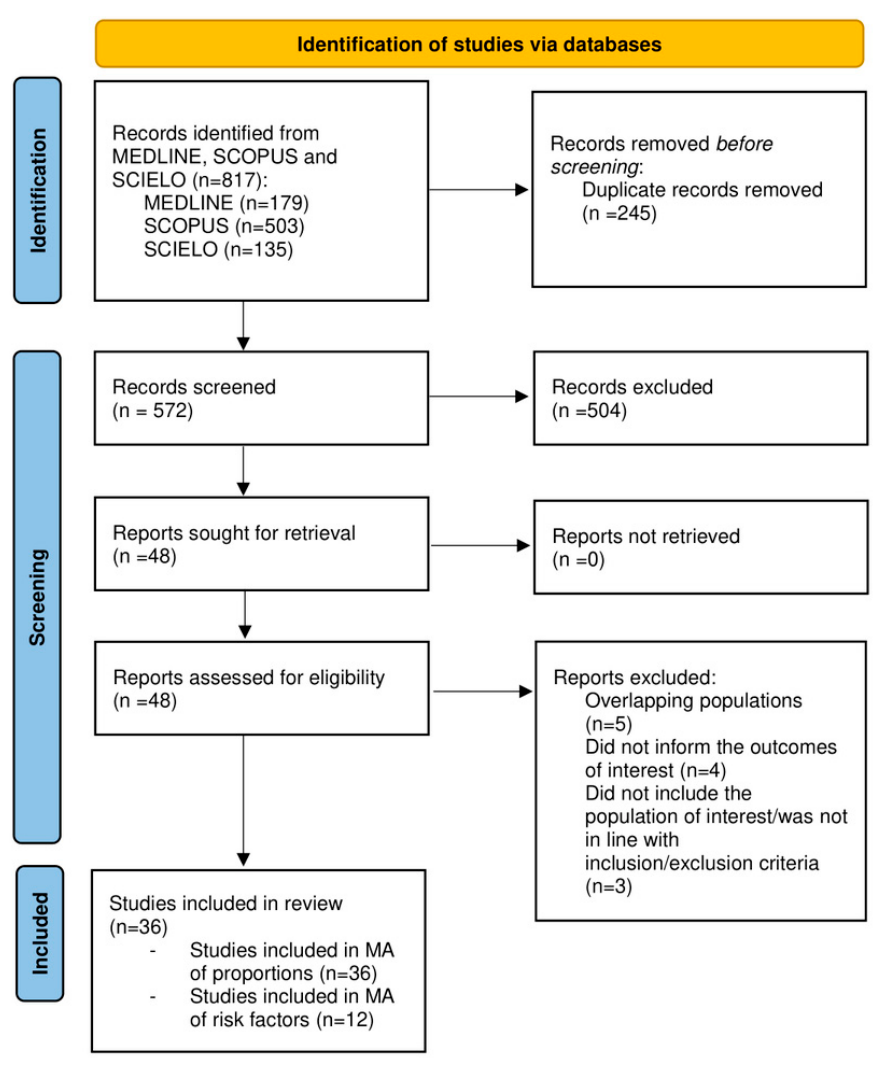
Figure 1. PRISMA diagram flow chart.